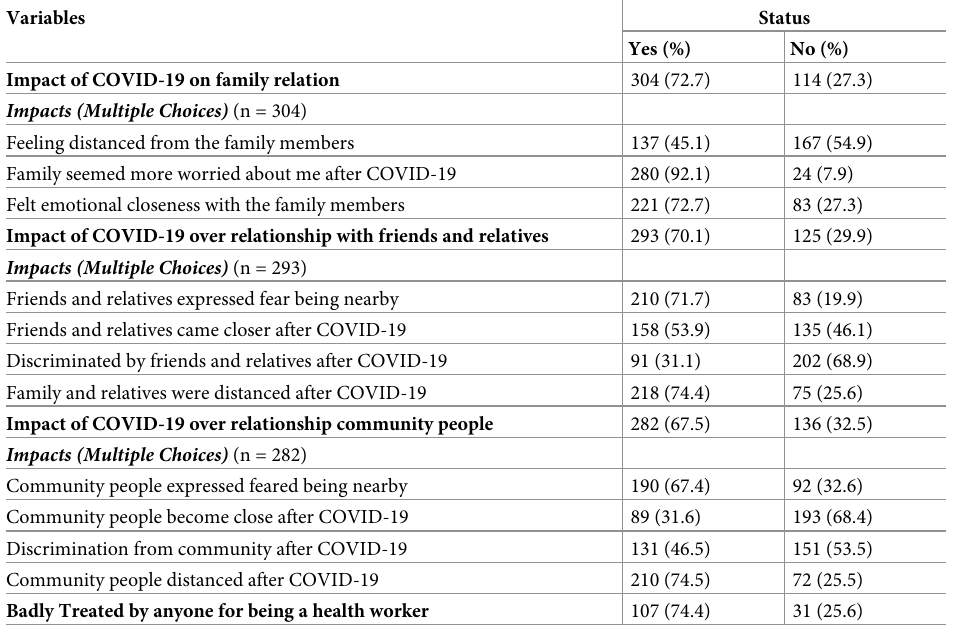
Table 4. Social impact experienced by the health professional during COVID-19 (n = 418).